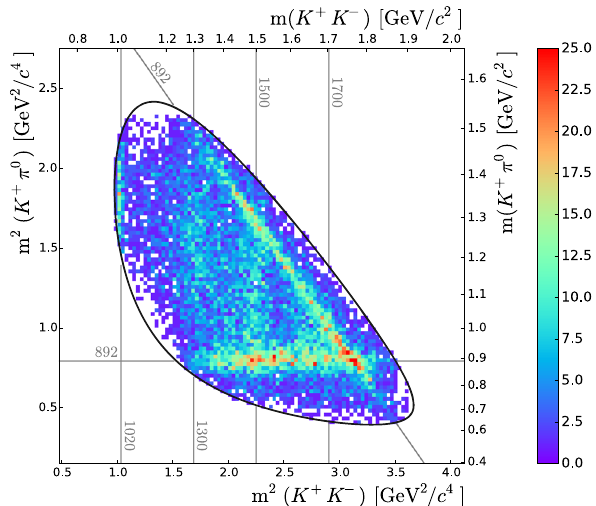
Fig. 5 Dalitz plot for the K + K − π 0 data after application of the back- ground suppression, not corrected for acceptance. Some resonance masses of interest are marked with thin black lines and gray labels